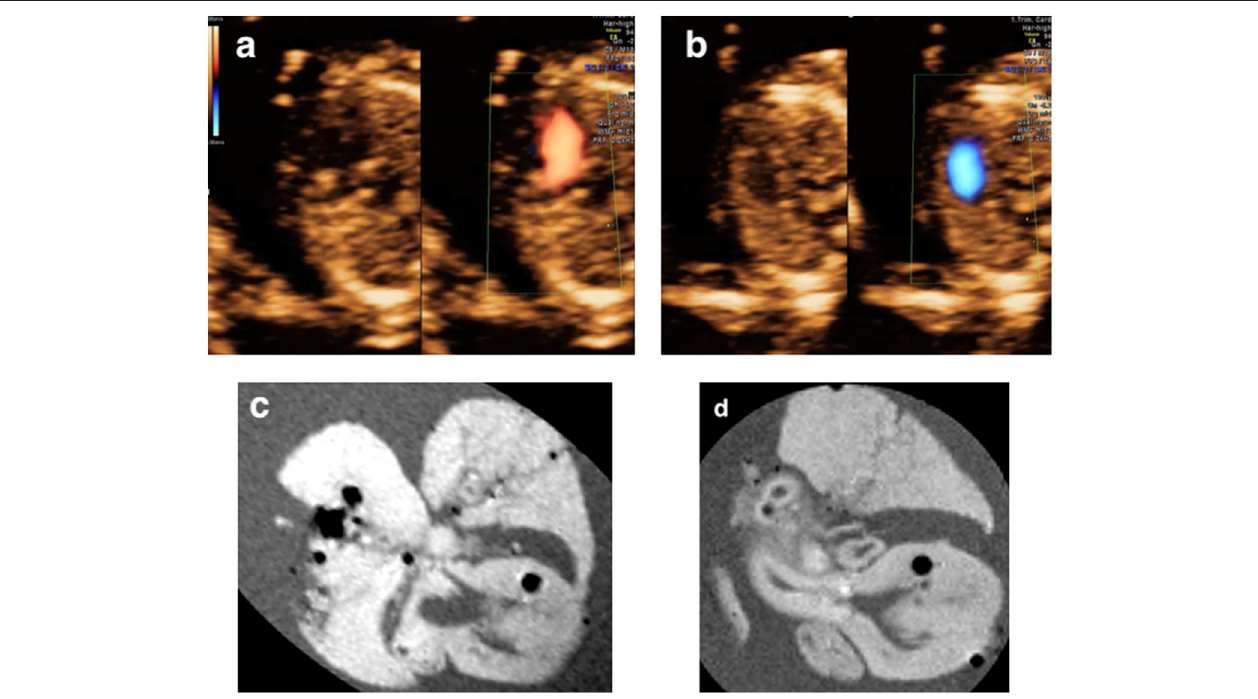
FIGURE 7 | (a,b) A fetus terminated at 13 + 5 weeks of gestation and diagnosed as AVSD and suspected of great vessels malformation (Case 2 in Table 2 ); (c,d) Post-mortem MRI showing the AVSD at the four-chamber view and an overriding aorta at left ventricle outflow tract view.